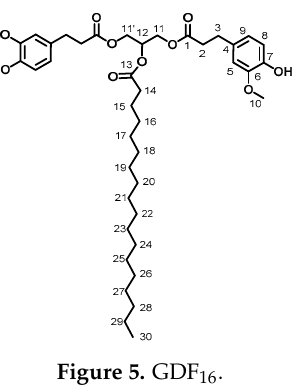
Figure 5. GDF 16.